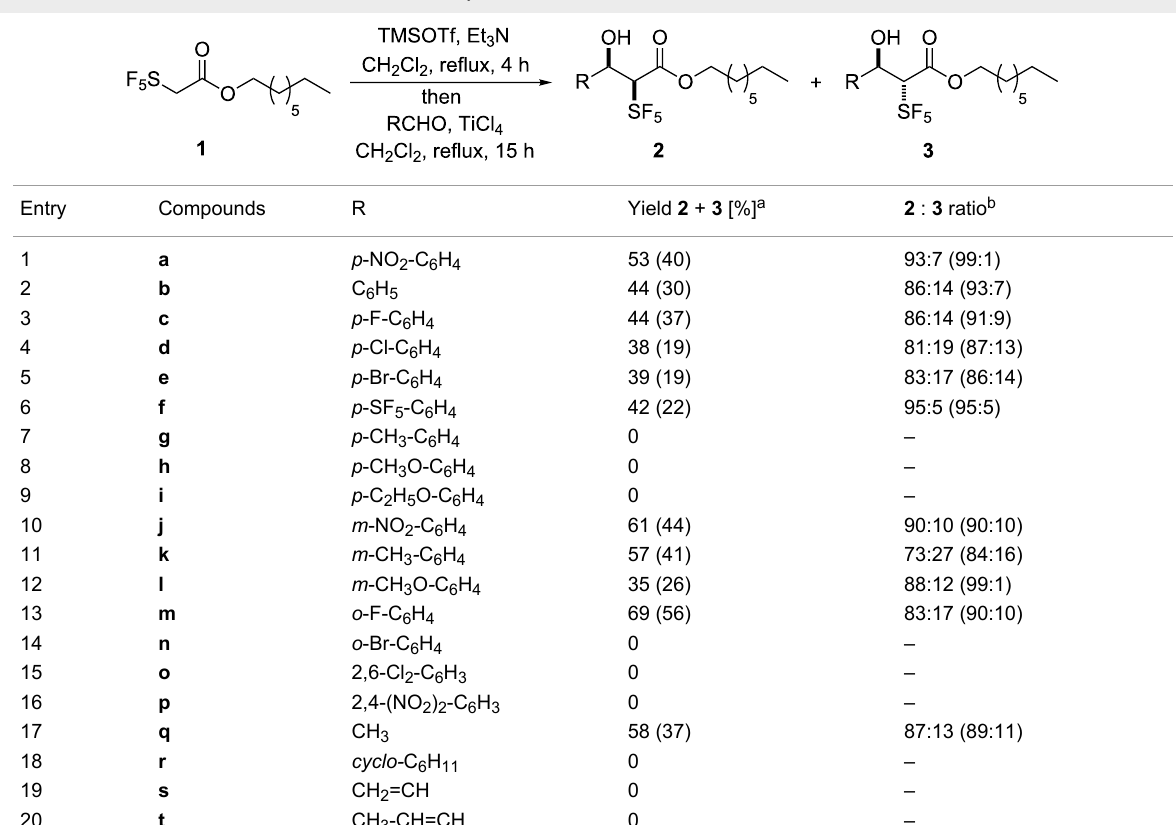
Table 2: Results of reactions of ester 1 with different